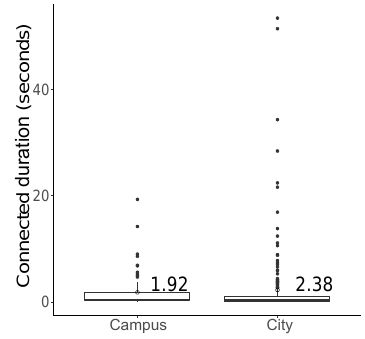
Figure 13. Average connection time while travelling through the campus and city.